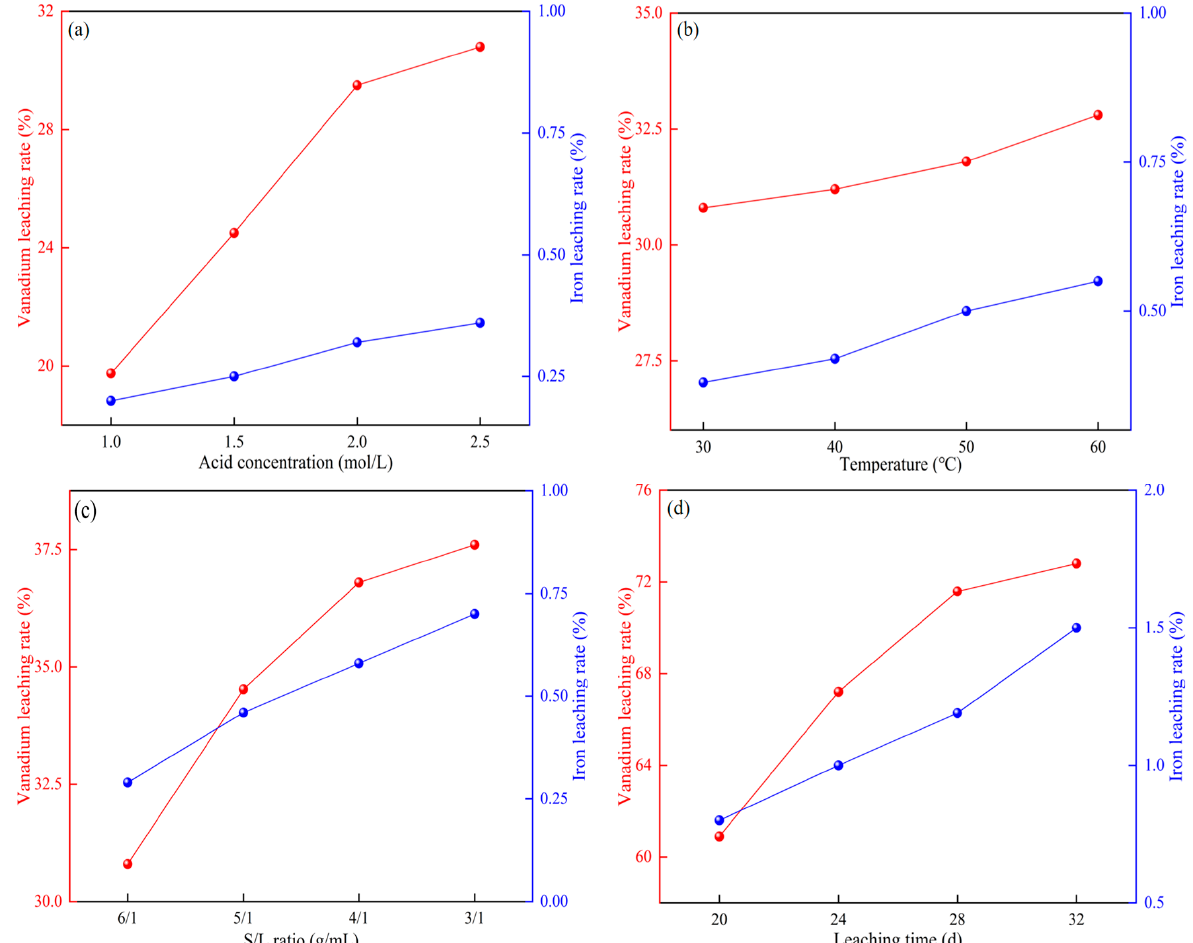
Figure 4. Effects of ( a ) acid concentration, ( b ) temperature, ( c ) solid–liquid ratio and ( d ) leaching time on the leaching rate of vanadium and iron.